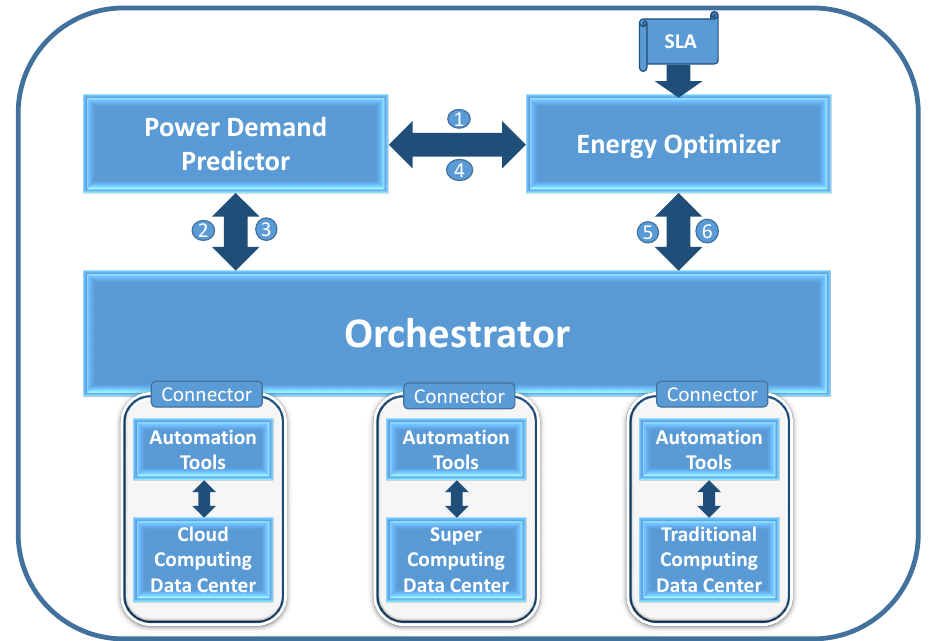
Figure 1. An energy management system (EMS) for minimizing the energy consumption inside data